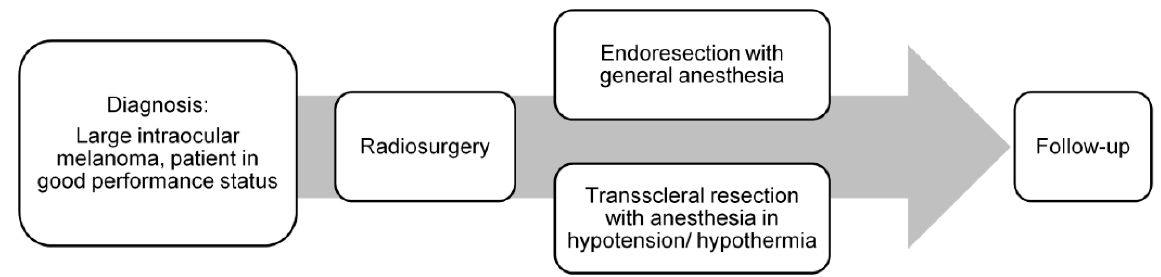
Figure 1. Treatment schedule: image-guided volumetric modulated arc radiosurgery, followed by resection.